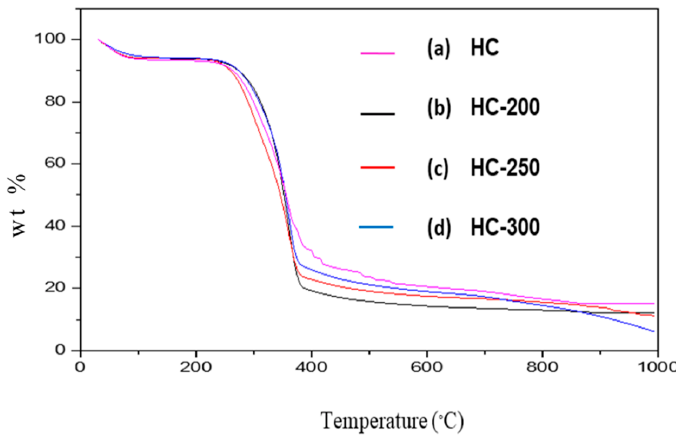
Figure 2. Thermogravimetric curves for ( a ) Raw Holocellulose (HC) and corresponding carbon micro-spheres produced at various temperatures ( b ) HC-200; ( c ) HC-250; and ( d )